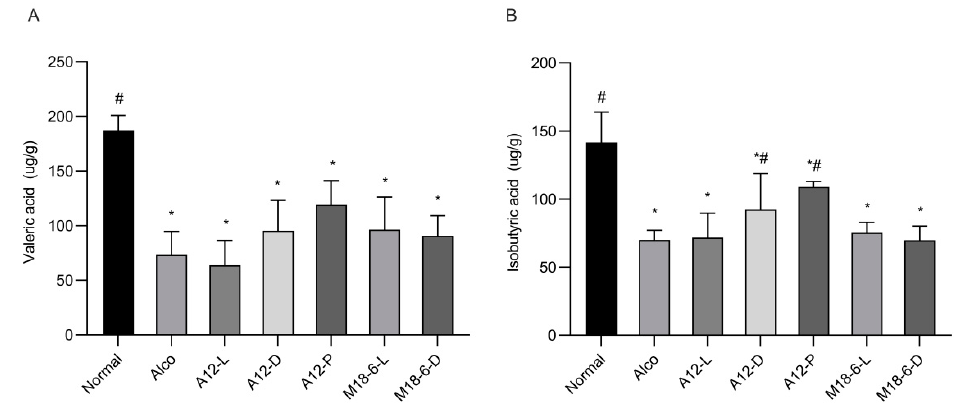
Figure 6. Short-chain fatty acid level in mice. ( A ): Valeric acid; ( B ): Isobutyric acid. Compared with normal group ( p < 0.05) *, compared with Alco group ( p < 0.05) #. Normal: normal saline-fed; Alco: alcohol-fed group; A12-L: alcohol-fed with live B. animalis A12 cells group, A12-D: alcohol-fed with dead B. animalis A12 cells group, A12-P: alcohol-fed with B. animalis A12 freeze-dried power group, M18-6-L: alcohol-fed with live L. salivarius M18-6 cells group, and M18-6-D: alcohol-fed with dead L. salivarius M18-6 cells group.